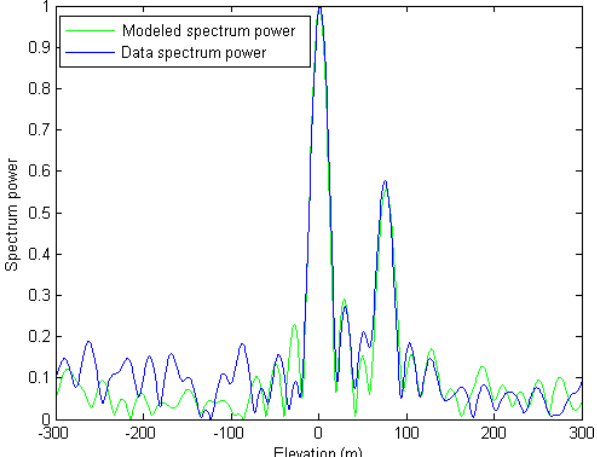
Figure 4. Distinguishing single- (red) and layover scattering (blue) points using PSI with FFT on a stack of Sentinel-1A IW images of Beijing (Sentinel-1A data ©ESA